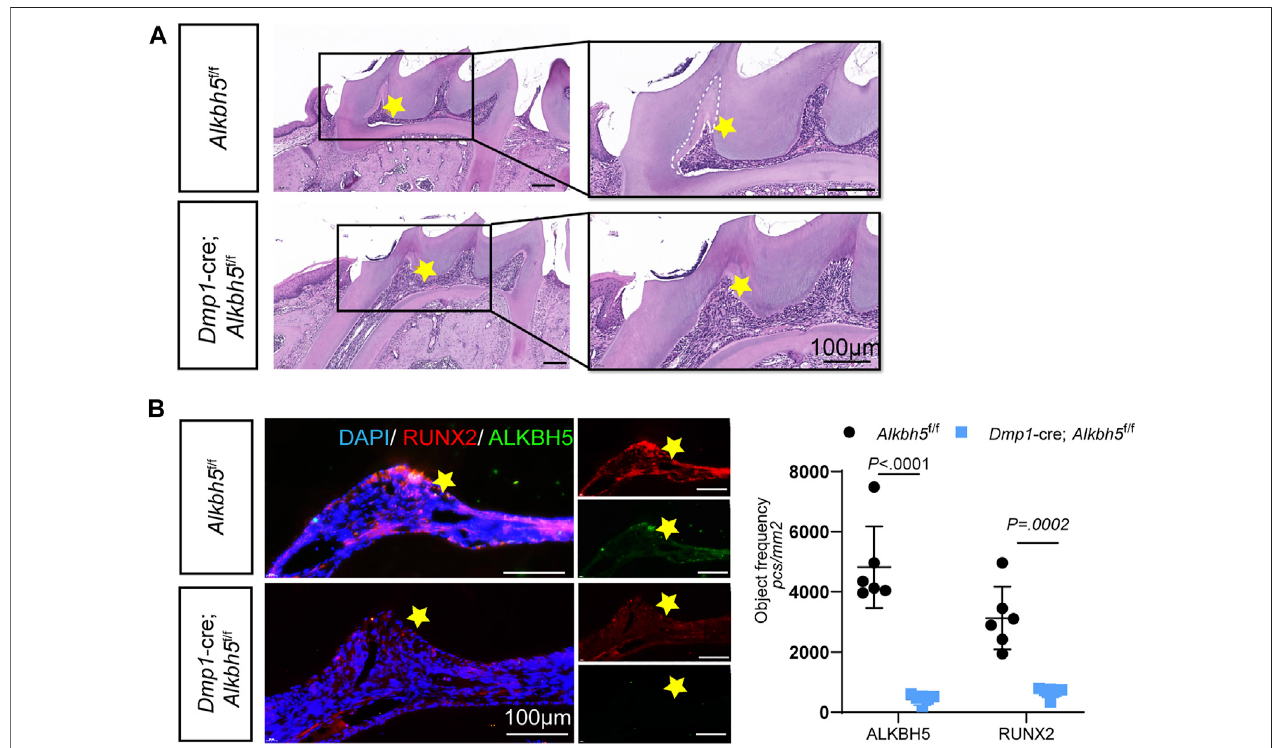
FIGURE 7 | Impaired tertiary dentin formation in Dmp1 -Cre; Alkbh5 fl / fl mice. (A) Representative H&E staining of the maxillary fi rst molar structure in the Dmp1 -Cre; Alkbh5 fl / fl and Alkbh5 fl / fl mice after drilling for 14 days. The formation of tertiary dentin formation occurred in the proximal mesial pulp chamber near the defect. Tertiary dentin formation was inconspicuous in Dmp1 -Cre; Alkbh5 fl / fl mice. Asterisks (*) indicate the pulp horn and dotted lines indicate the boundaries between primary dentin and tertiary dentin. (B) The expression of ALKBH5 and RUNX2 in maxillary fi rst molars was detected via immuno fl uorescence. Quantitative analyses of the expression of ALKBH5 and RUNX2 in Dmp1 -Cre; Alkbh5 fl / fl and Alkbh5 fl / fl mice. Scale bar: 100 μ m Alkbh5, AlkB homolog H5; H&E, hematoxylin and eosin.